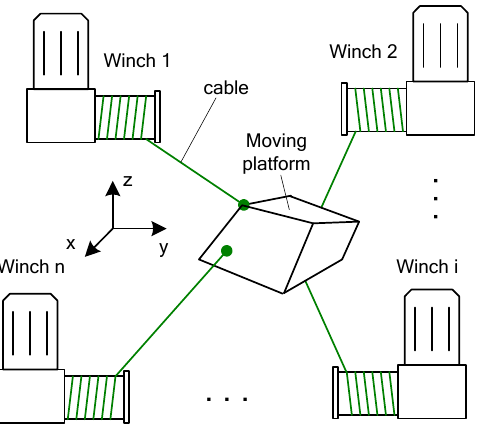
Figure 1. Structure of the cable-driven parallel robot (CDPR).